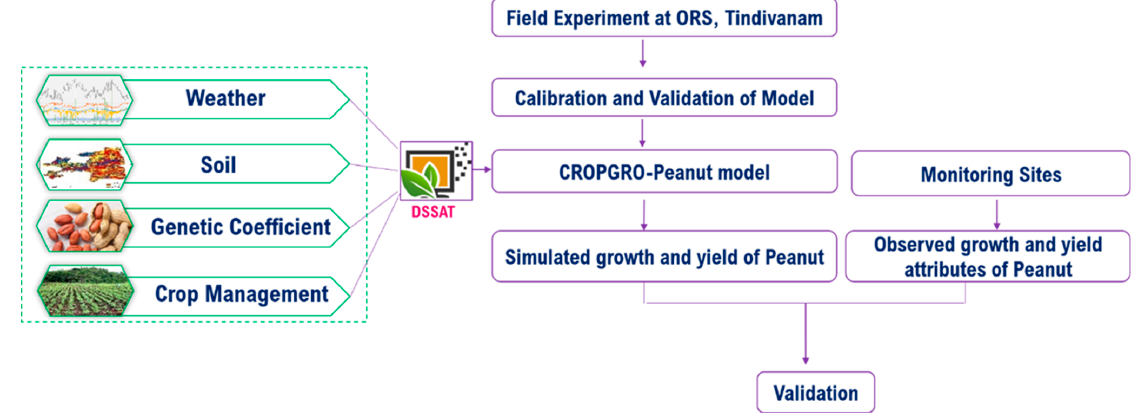
Figure 3. Diagram of database, application and support software components in DSSAT.